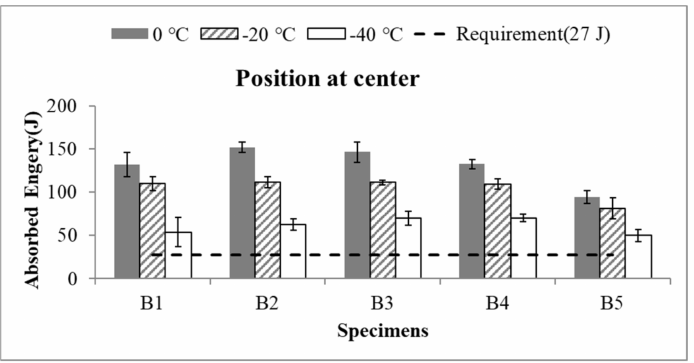
Figure 10. Results of Charpy impact test for welding center of butt-welding joint.